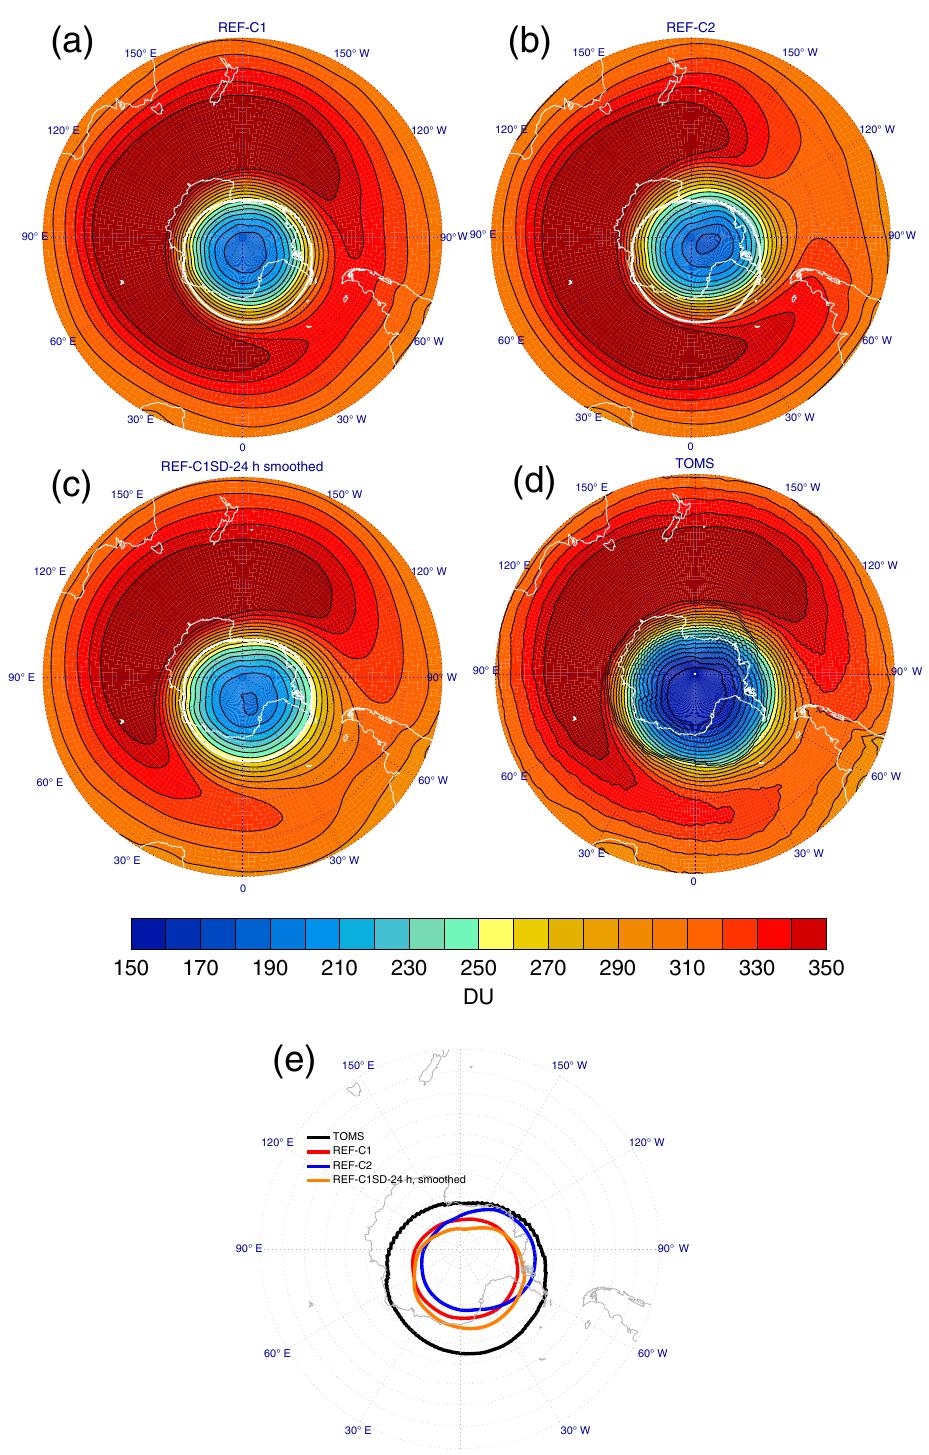
Figure 14. Climatological TCO during October in the Southern Hemisphere for (a) REF-C1, (b) REF-C2, (c) REF-C1SD-24h (smoothed), and (d) TOMS. Panel (e) indicates the ozone hole, defined as the 220 DU contour. White contour in (a) , (b) , and (c) shows TOMS 220 DU contour. TCO in REF-C1SD is still biased high, but the ozone hole has the correct shape. The years 1997–2002 are used in all